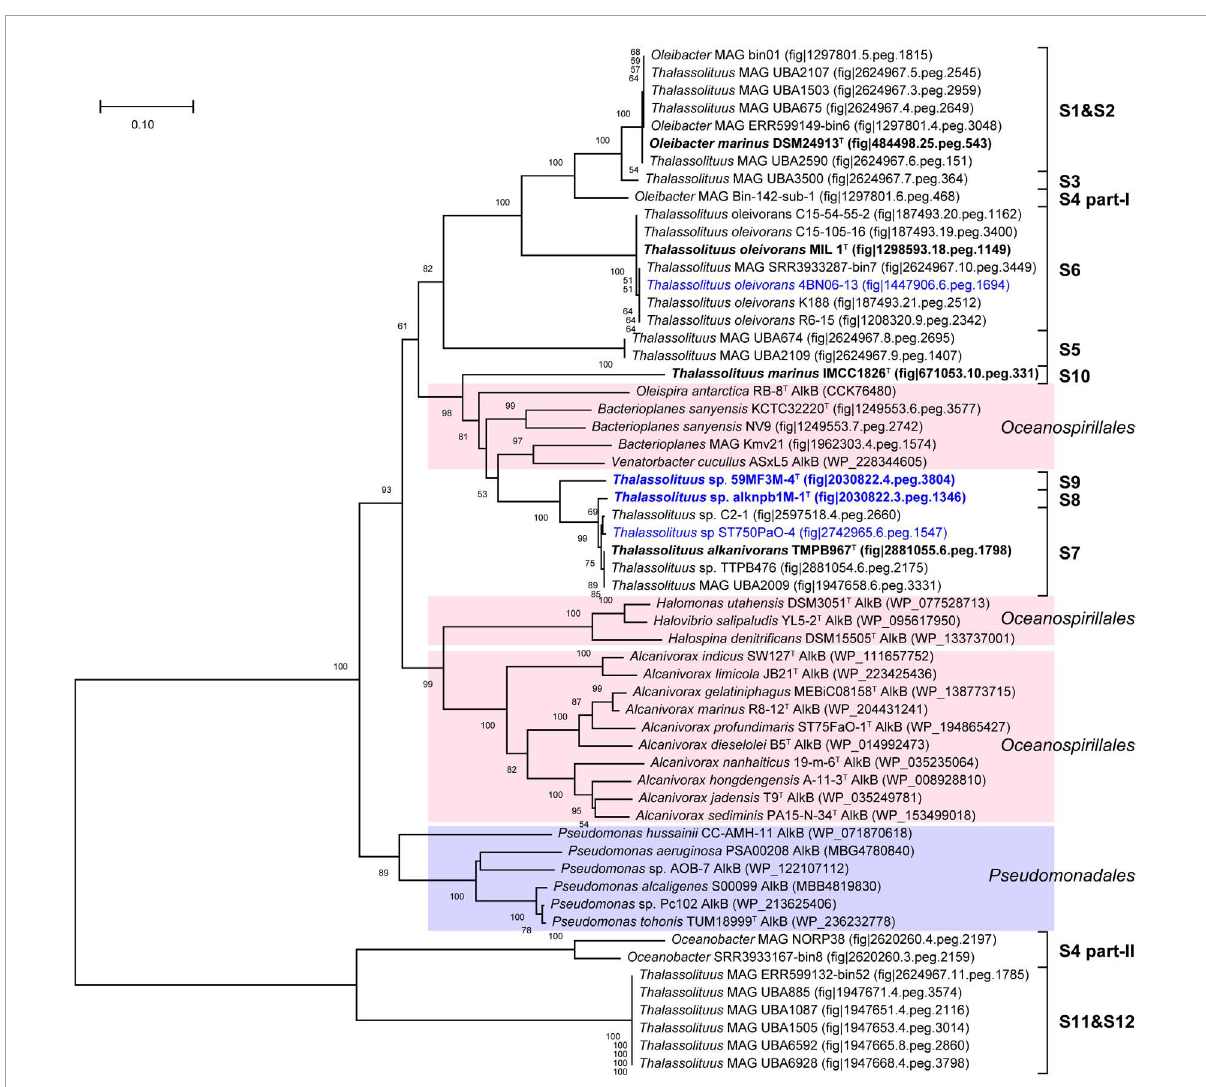
FIGURE6 Neighbor-joining phylogenetic tree of alkane monooxygenase AlkB1 protein sequences derived from hydrocarbon-degrading (HD) group strains of the Oceanobacter -related bacteria (ORB) and their closest reference sequences. Bootstrap values ( > 50%) based on 1,000 resamplings are given at the nodes. The labels in blue and black bold font indicate the sequences obtained from the strains isolated in this study and the type strains of the ORB, respectively. Reference sequences in different shades of color indicate that they originated from different bacterial orders: red, Oceanospirillales ; purple, Pseudomonadales